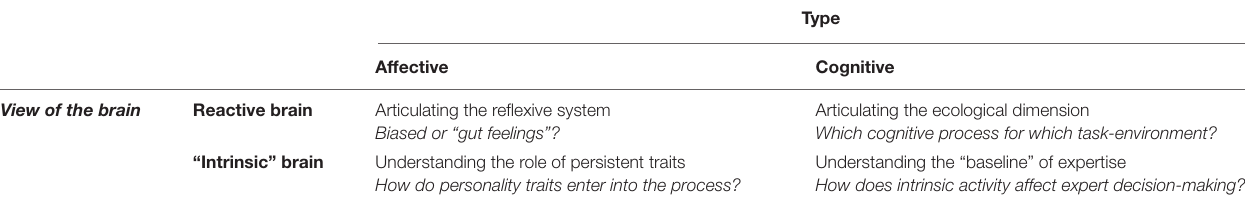
TABLE 2 | A potential typology of future